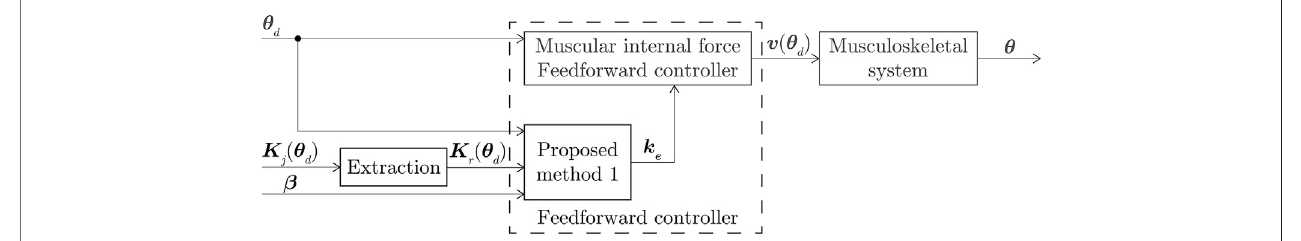
FIGURE 2 | Block diagram of MIF controller using proposed Method 1.